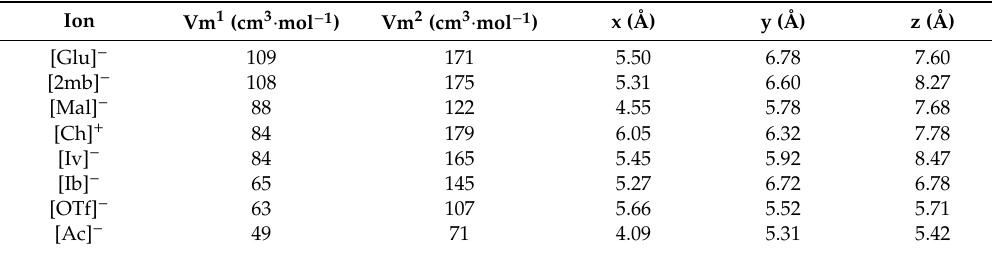
Table 5. Molar volumes and closest-fitting box dimensions of the ions in the ILs.